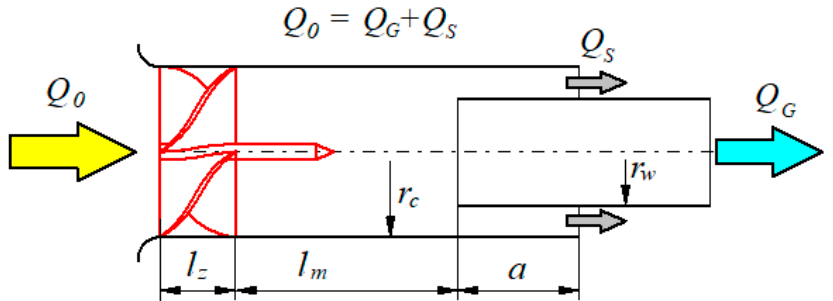
l m —separation length of the cyclone, S —steering wheel travel (helix pitch).